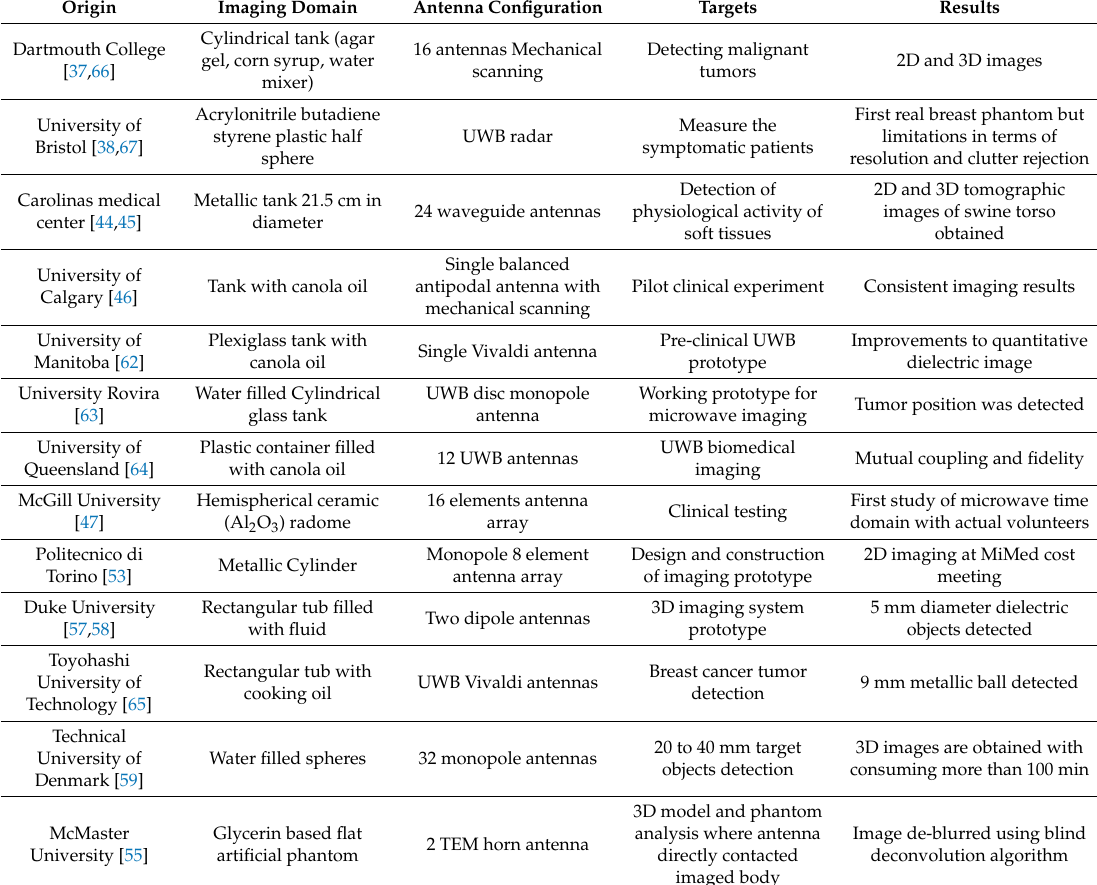
Table 2. Summarized Table of UWB